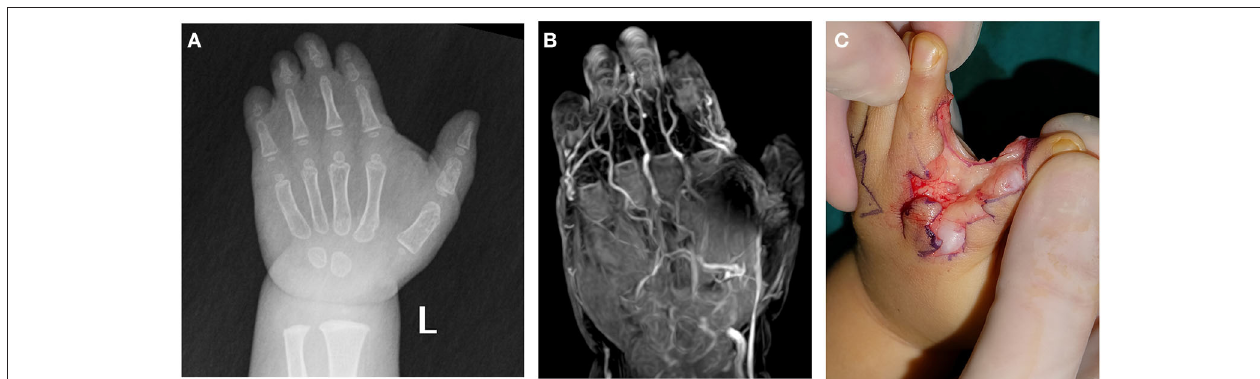
FIGURE 2 | A 17-month-old female patient with complicated syndactyly of the left 2nd-3rd-4th-5th digits. (A) The preoperative radiograph showed the fused extent of soft tissues of the 2nd-3rd-4th-5th webspaces and only two phalanges of the 3rd-4th-5th digits. (B) A contrast-enhanced three-dimensional water selective cartilage scan indicated that the bifurcation positions of three common palmar digital arteries of the hand shifted distally to approximately one-third of the proximal phalanges. (C) These findings were completely consistent with the intraoperative observation results.